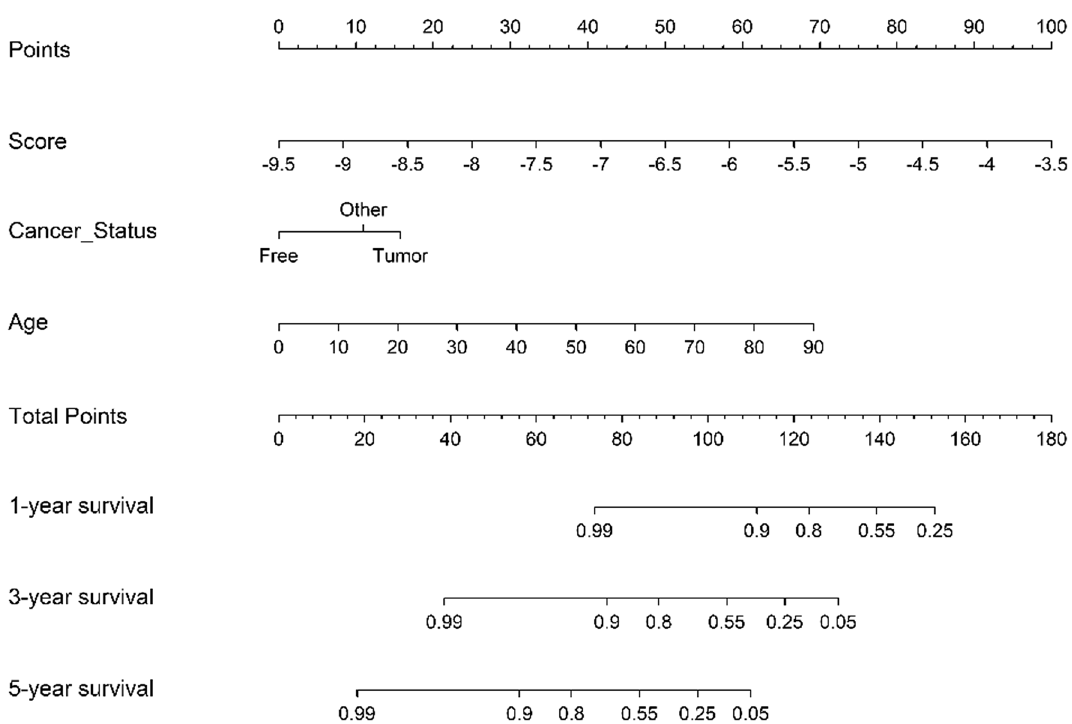
Figure 7. In order to quantify the risk assessment and survival probability for individual stage I–II LUAD patients, a nomogram was developed in the entire TCGA dataset according to the 11 DNA methylation signature-based risk score, age and cancer